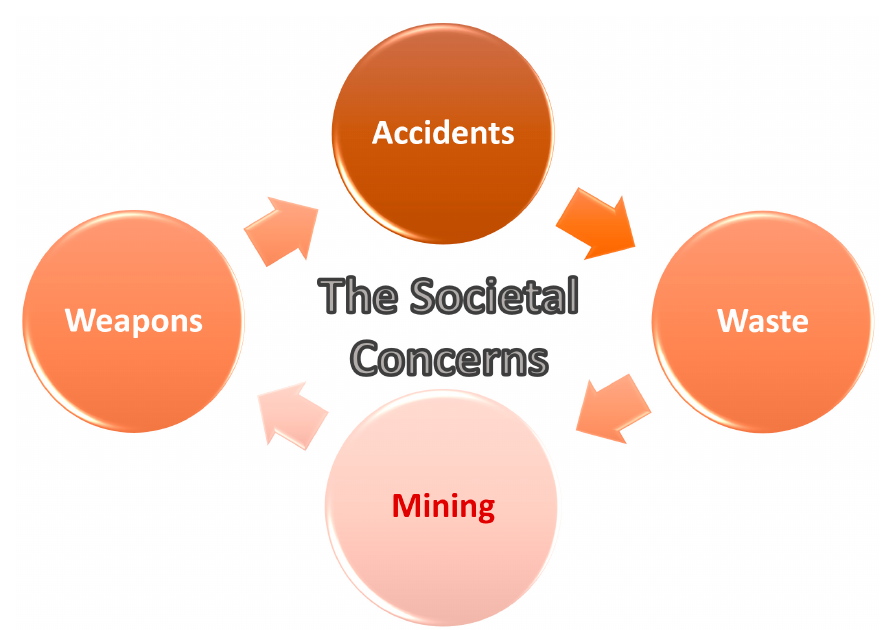
Figure 1. The societal concerns influencing the perception of nuclear energy at a